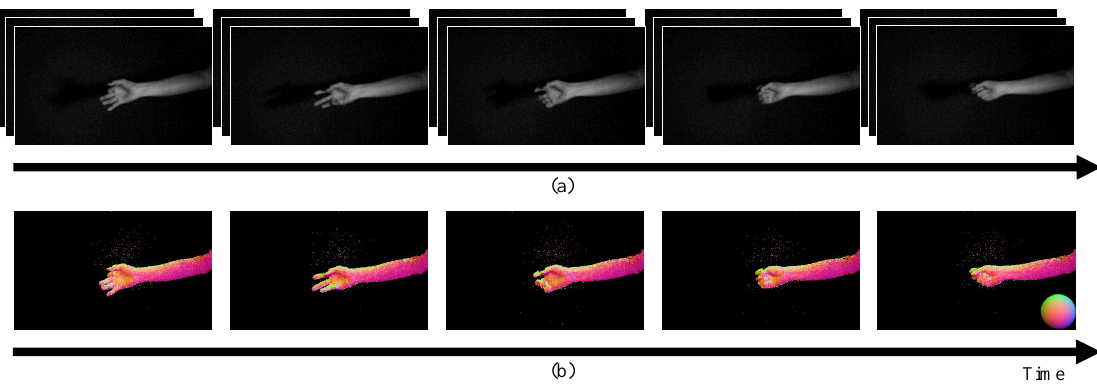
Figure 12. Results obtained using the photometric stereo method for a dynamic scene composed of a hand grasping. ( a ) shows the images that were captured using the multi-tap CMOS image sensor, and ( b ) shows the normal maps that were estimated based on these images. We were able to estimate the surface normals of the deforming object. To make the results easier to see, we modulated the brightness of the captured images to be 800% brighter than the original